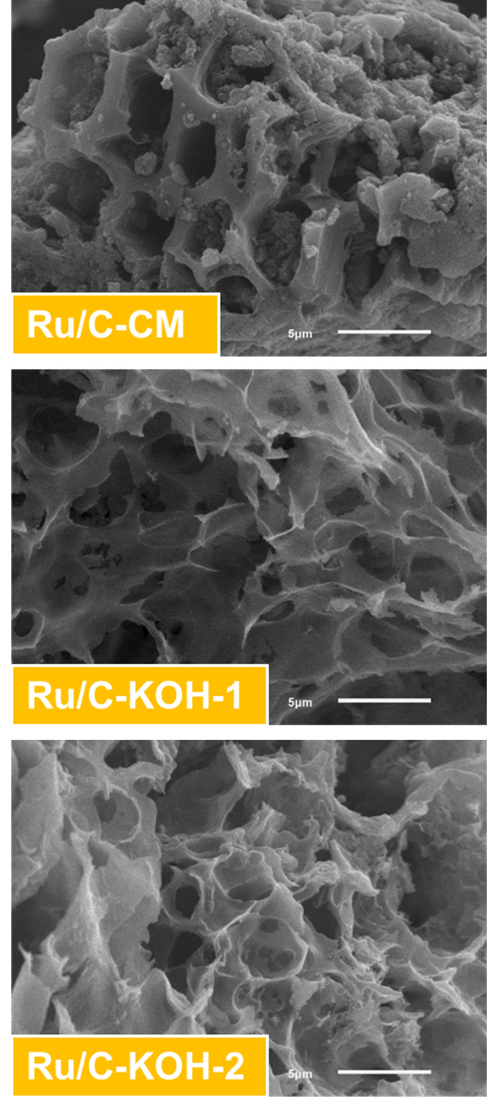
Figure 2. SEM image of investigated Ru/C catalysts.